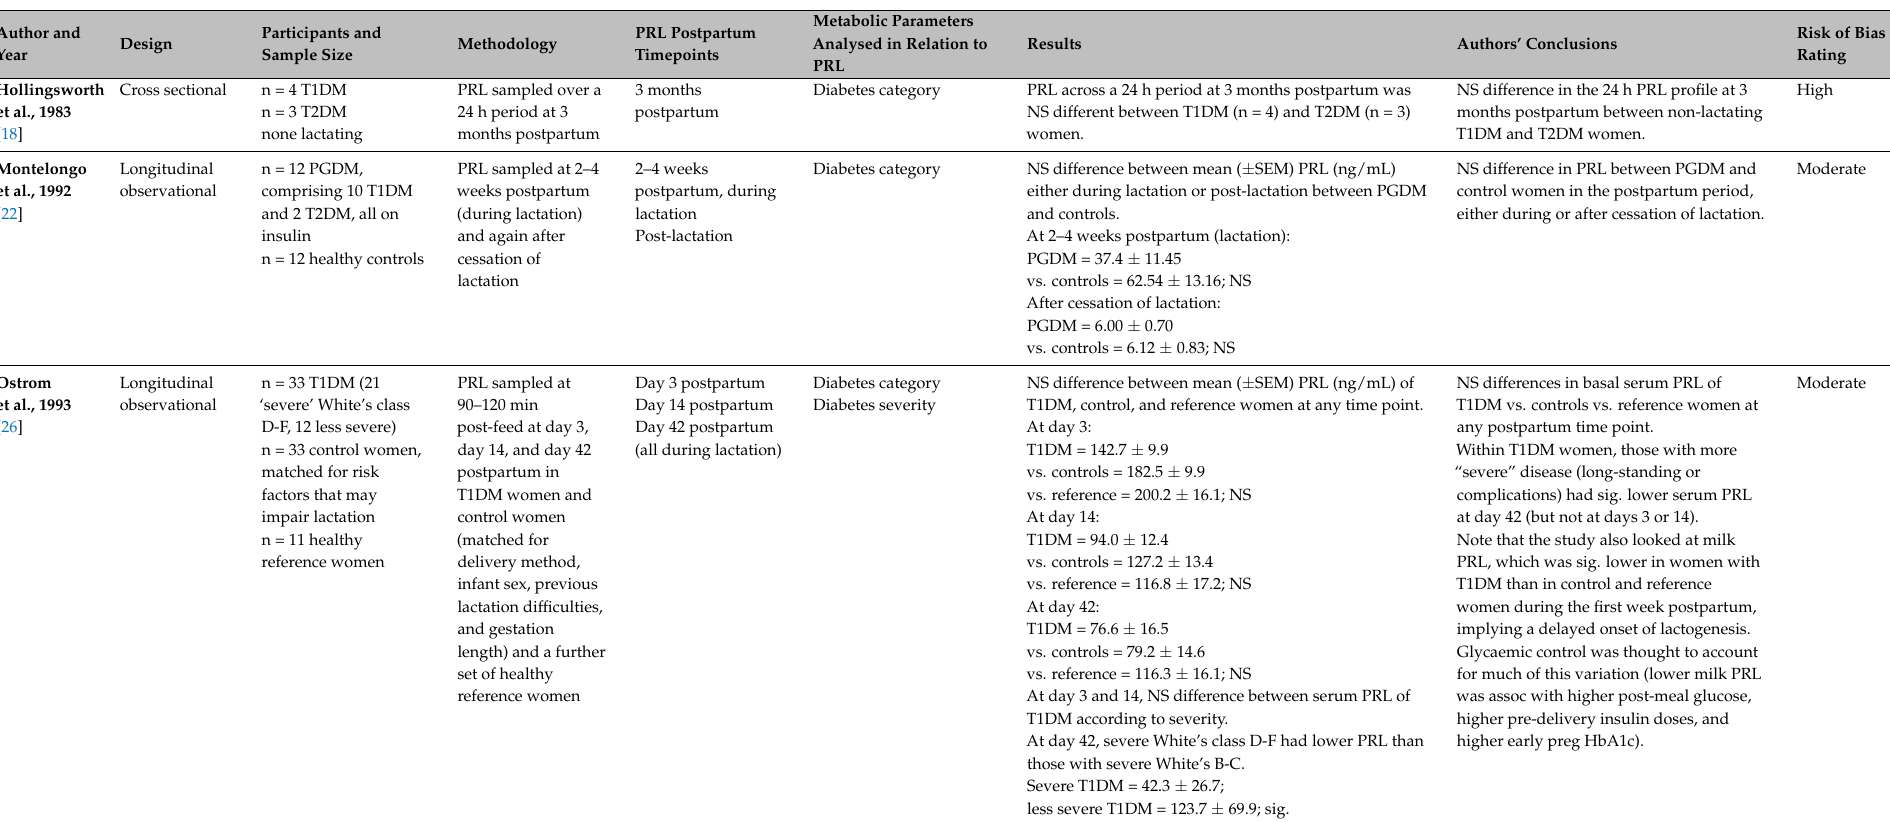
Table A3. Studies examining PRL postpartum/ during lactation in maternal T1DM/ T2DM—3